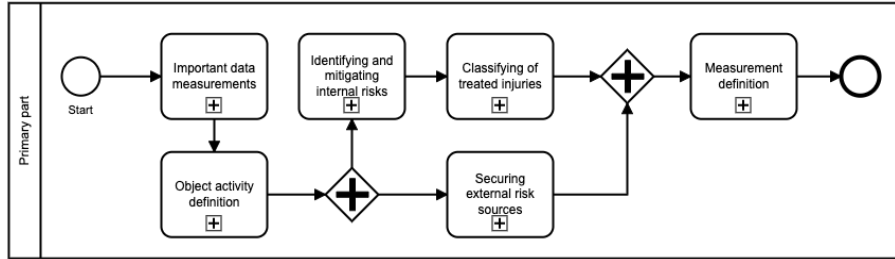
Figure 4. Primary part of pandemic